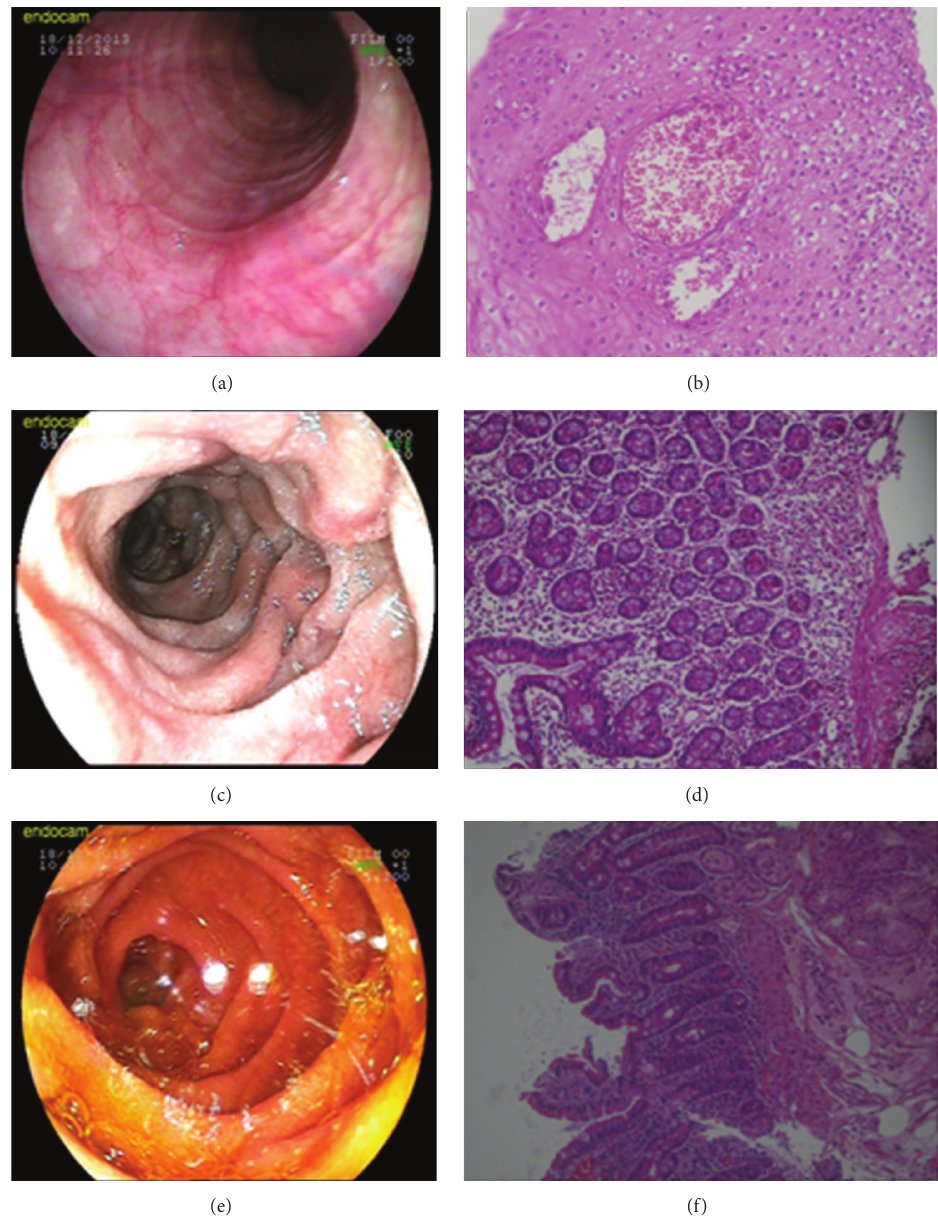
Figure 2: (a) Endoscopy reveals concentric rings (felinization). (b) Mucosal biopsy showed eosinophilic microabscess in the squamous epithelium (H&E stain, × 200). (c) Endoscopic examination showed extensive congestion and edema in duodenum. (d) Mucosal biopsy demonstrated eosinophilic infiltration with inflammatory cells in the lamina propria and submucosa (H&E stain, × 200). (e) On the follow-up endoscopy after 3 months, the duodenal mucosal congestion and edema are improved. (f) Biopsies were obtained at follow-up endoscopy that shows normal mucosal architecture (H&E stain, ×